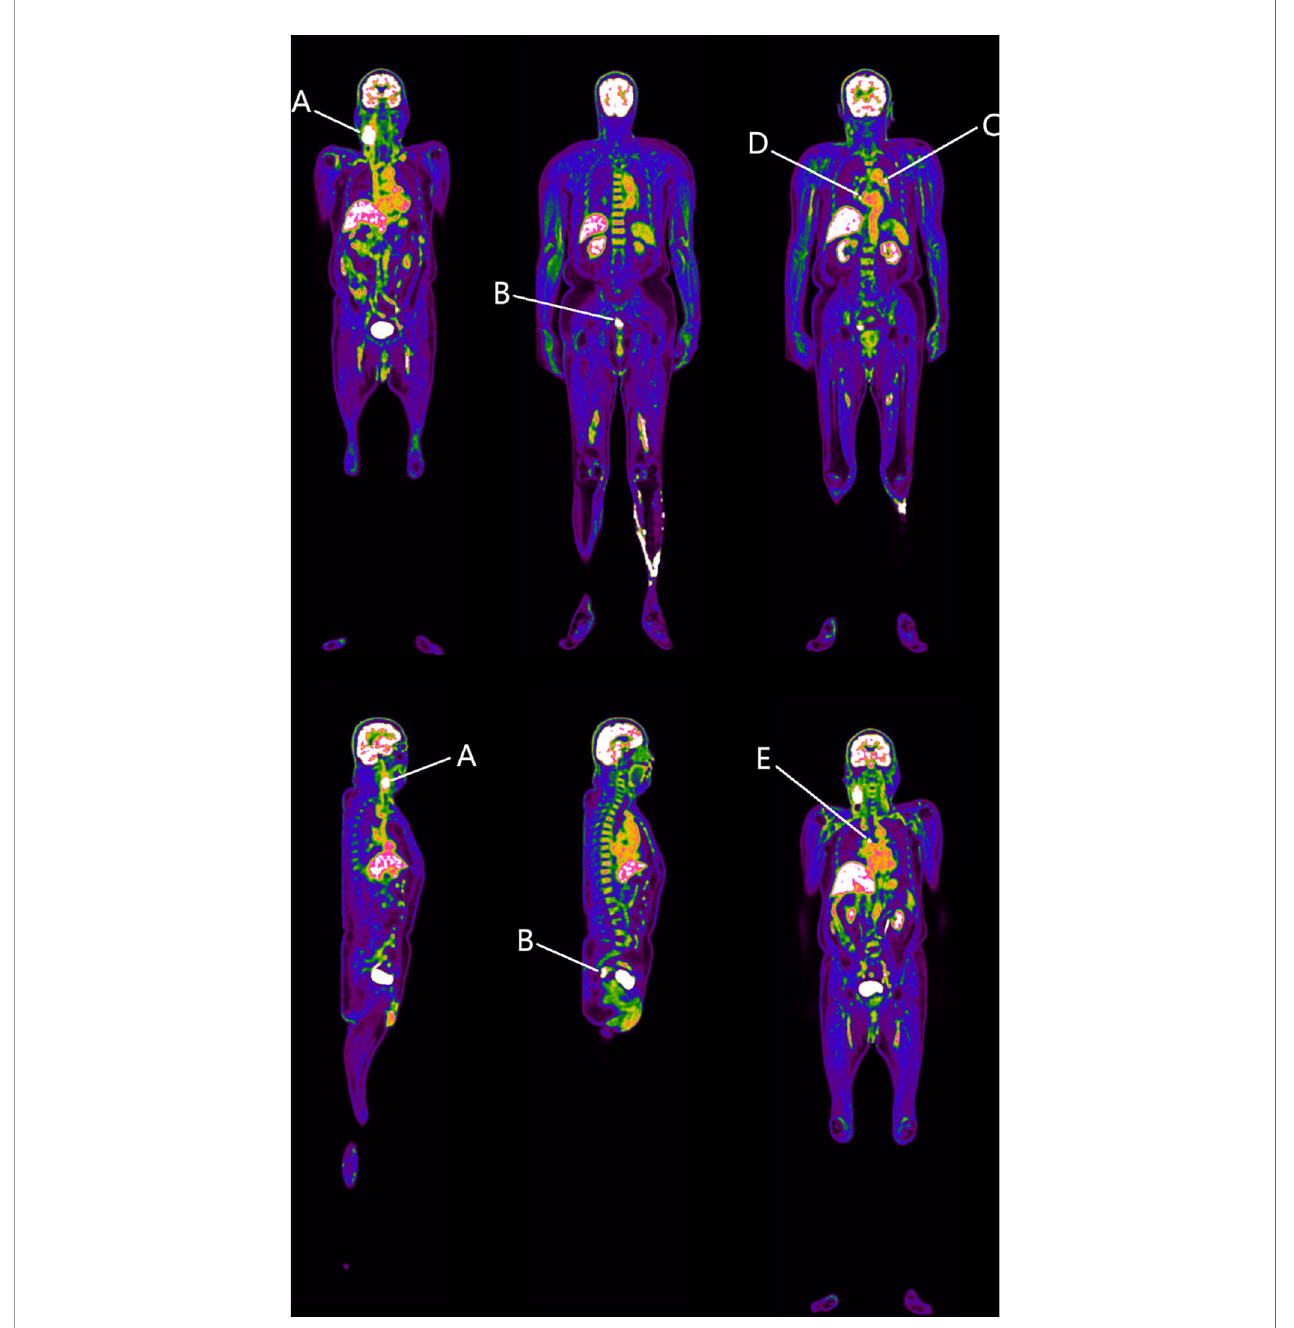
FIGURE 2 | Identi fi ed regions with increased 18F-FDG uptake. Region A represents the right neck space-occupying lesion. Region B resides in the rectosigmoid junction. Regions C – E denote the mediastinal lymph nodes. At this stage, we speculate that Region B is the possible primary tumor responsible for Region